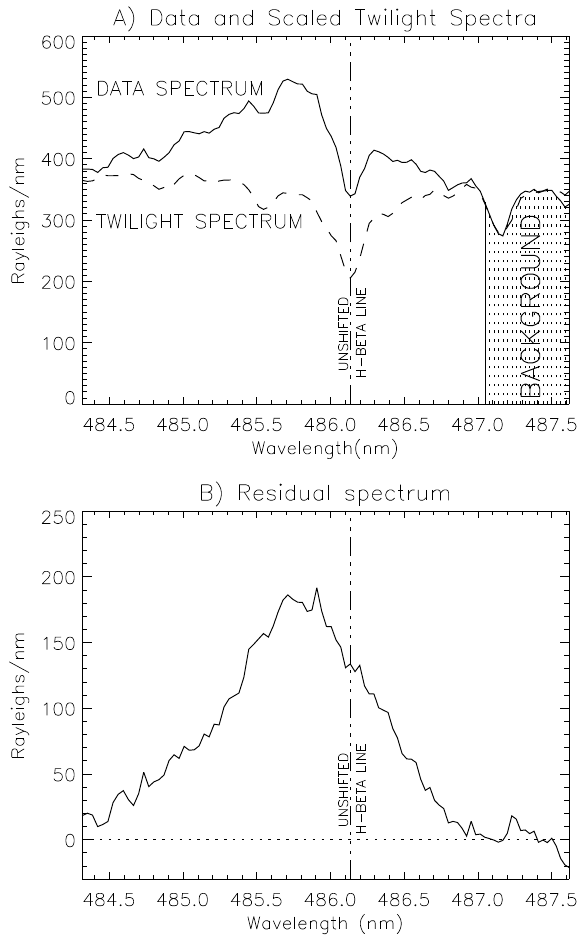
Fig. 5. (A) A measured spectrum (solid line), integrated for 60 s beginning at 09:21:57 UT on 27 November, 2000. The φ -scaled twilight spectrum is drawn as a dashed line. (B) The residual spec- trum after the scaled twilight spectrum has been subtracted from the data